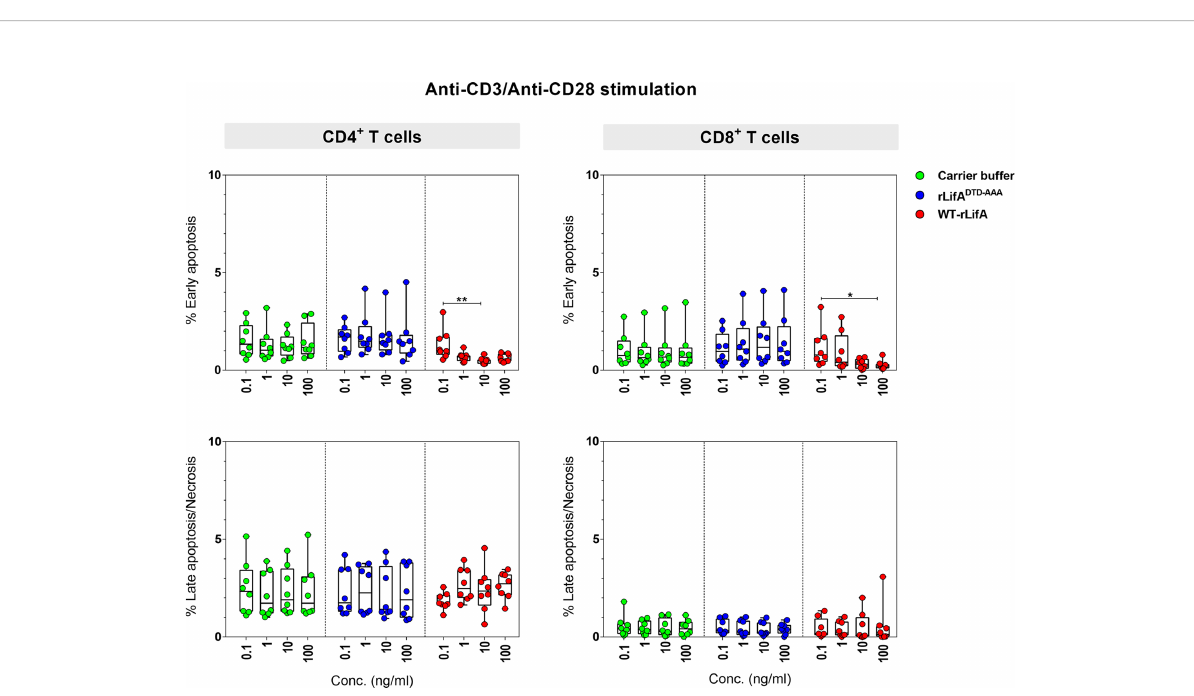
FIGURE 7 Lymphostatin induces neither apoptosis nor necrosis in anti-CD3/anti-CD28-stimulated CD4 + and CD8 + T cells. Box and whisker plots show the percentage of early apoptosis, and mixture of late apoptosis and necrosis in anti-CD3/anti-CD28-stimulated CD4 + and CD8 + T cells treated with WT-rLifA, rLifA DTD-AAA , or carrier buffer. Data represent the mean from 8 healthy donors. Symbols with circles represent data from the individual donors. * p < 0.05, ** p < 0.01 using Kruskal-Wallis test followed by Dunn ’ s